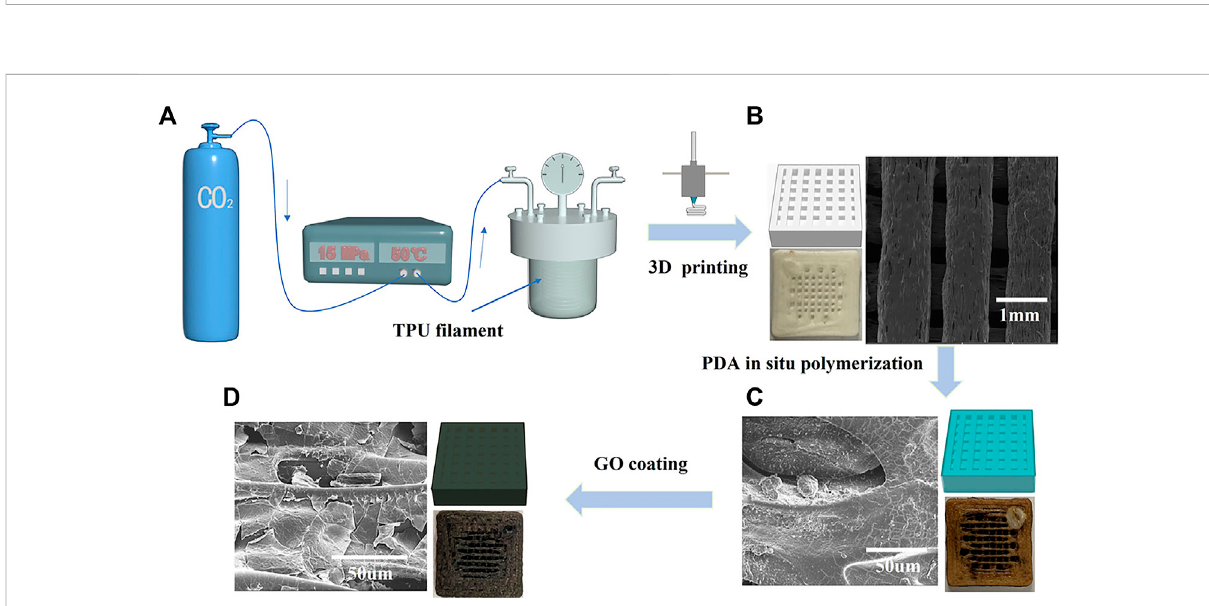
FIGURE 11 Schematic illustration of the fabrication for FFF printed TPU scaffold with microcellular foaming and surface coating with graphene oxide. Copyright 2022,